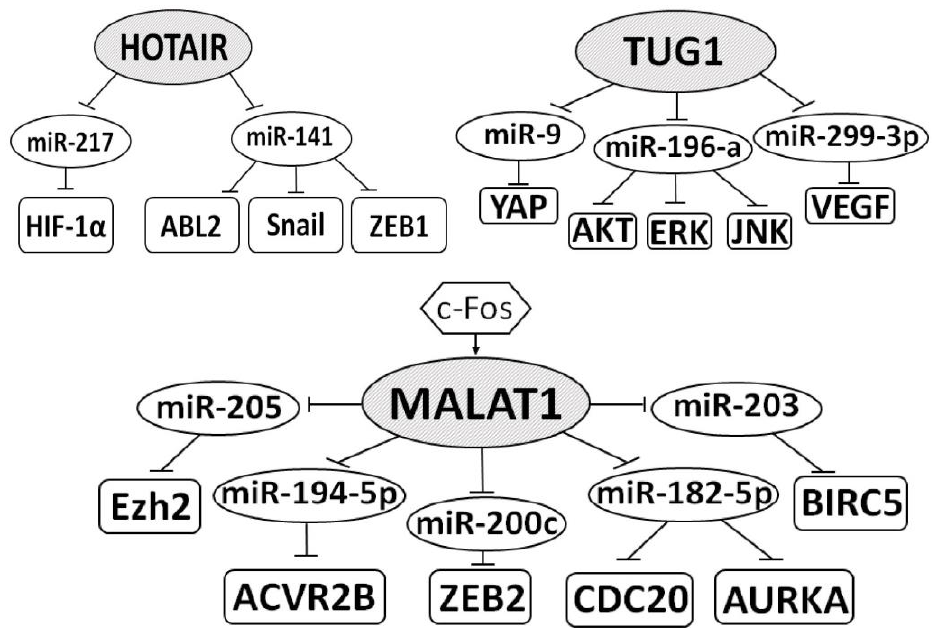
Figure 2. The regulatory axes of lncRNAs HOTAIR (HOX antisense intergenic RNA), MALAT1 (metastasis associated lung adenocarcinoma transcript 1), and TUG1 (taurine-upregulated gene 1), according to the following works [12,40,44,45,54–56,67–69]. lncRNAs are within the shaded ovals; miRNAs are within the unshaded ovals; proteins are within the rectangles; blunt arrows indicate inhibitory interactions; a straight arrow indicates activation of MALAT1 by c-Fos.